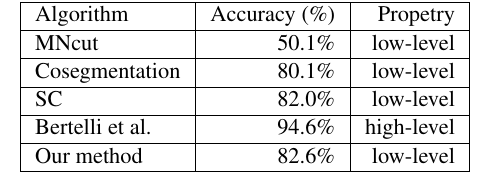
Table 1: Average pixelwise accuracy of five methods on